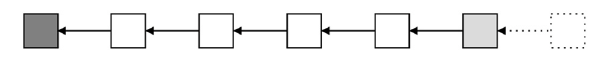
FIGURE 1 | A blockchain architecture diagram. At the far left side, the dark gray represents the genesis block, i.e., the first block in the chain. The white represents four regular blocks forming the blockchain. The light gray represents the tip block, the last block of the blockchain. At the far right side, in dashed line, an example of where a potential future block can be attached is